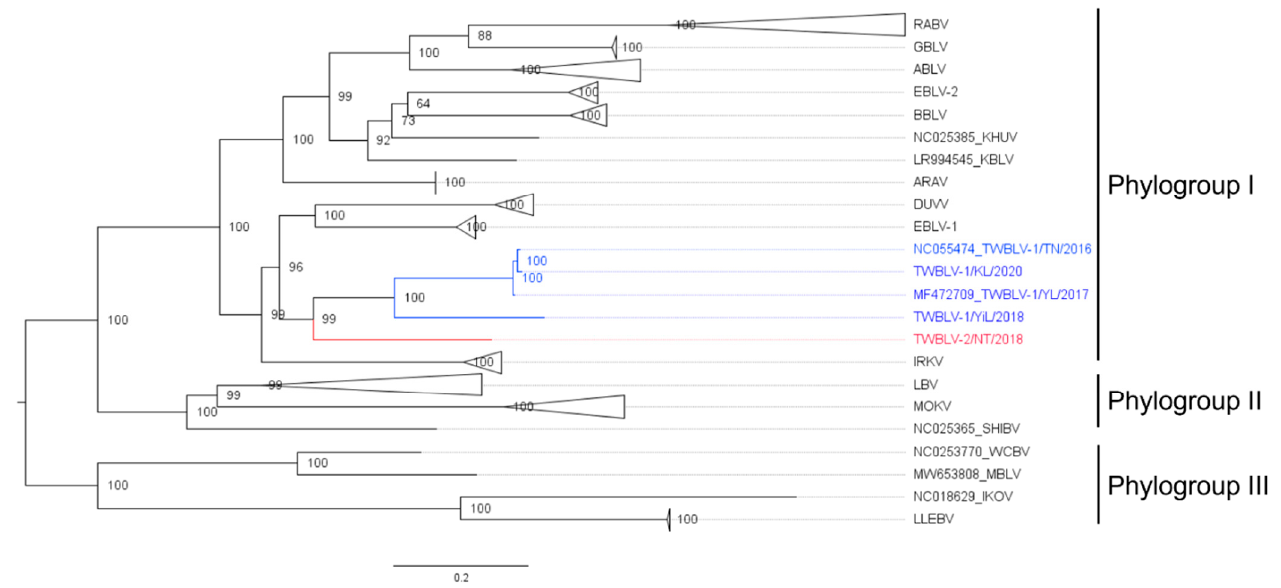
Figure 1. Phylogenetic relationship of a novel lyssavirus (red font) identified in Nyctalus plancyi velutinus in 2018, Taiwan. The nucleotide sequences of representatives of all lyssavirus species and their isolates from GenBank were analyzed. The Taiwan bat lyssavirus 1 isolates discovered in Taiwan were marked in blue font. The maximum likelihood phylogeny was constructed with full-length nucleoprotein sequences by IQ-TREE using the best fit model of nucleotide substitution with 1000 ultrafast bootstrap. Numbers at the nodes indicate ultrafast bootstrap supports. The phylogroup III lyssavirus were used as the outgroup. A clade composed of the same lyssavirus species was collapsed, and the species names are labeled on the right. The scale bar indicates the number of substitutions per site. The detailed phylogenetic tree with accession numbers of all genomes is shown in Figure S2. ABLV, Australia bat lyssavirus; ARAV, Aravan lyssavirus; BBLV,